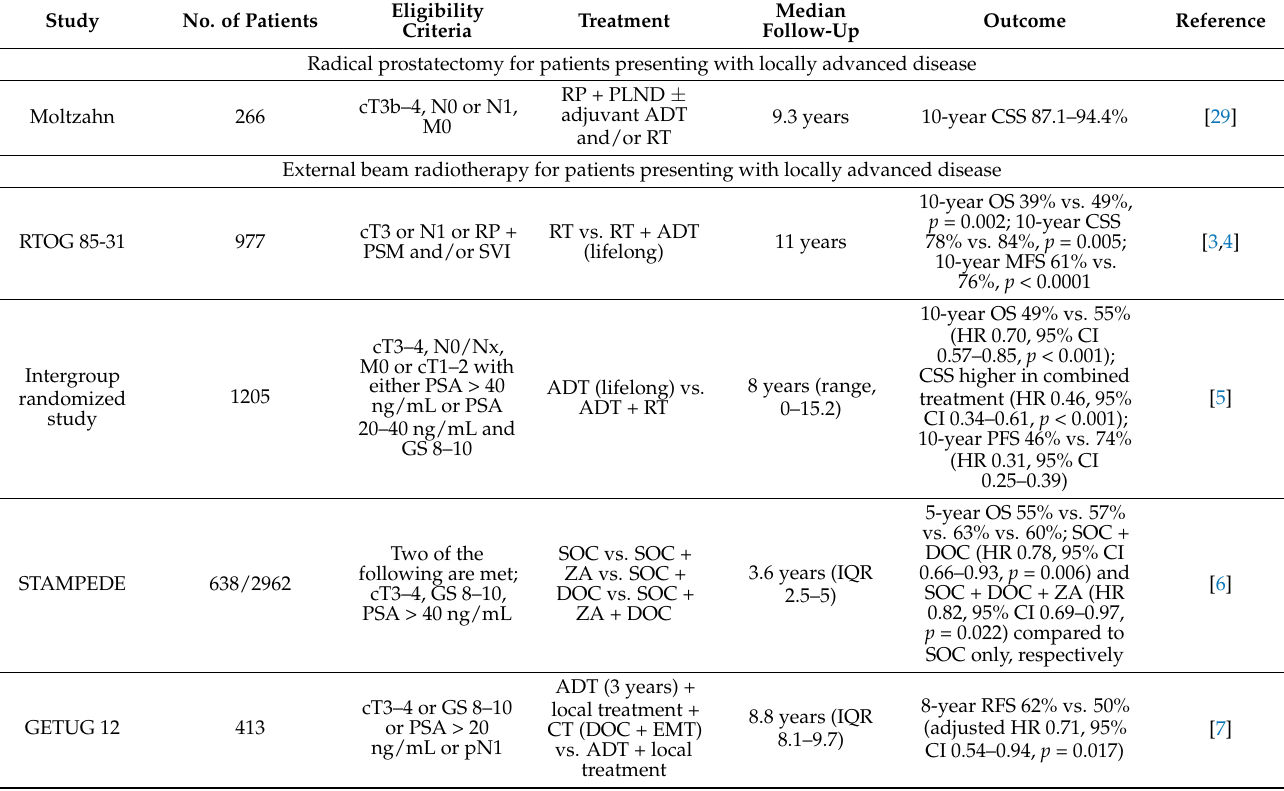
Table 2. Summary of the treatment of high-risk localized and very high-risk prostate